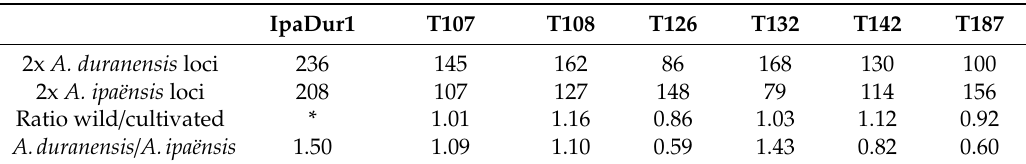
Table 5. Summary of genotyping of six selected lines on the Axiom Arachis SNP array. Number of total A. duranensis or A. ipaënsis characteristic loci surveyed, number of double doses A. duranensis loci, number of double doses A. ipaënsis loci, ratio of wild to cultivated alleles and ratio of A. duranensis to A. ipaënsis alleles. 904 polymorphic loci were surveyed.